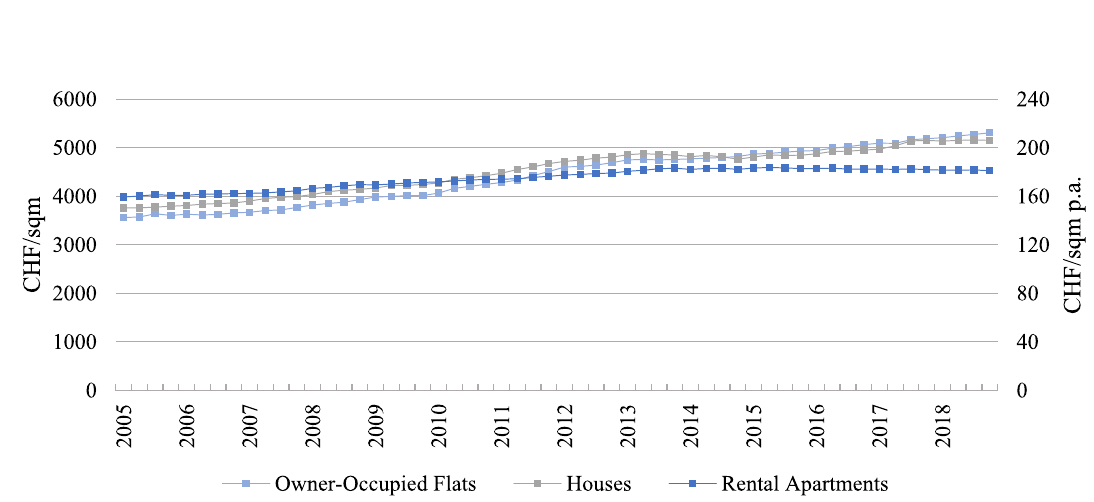
Fig. 5 Residential housing—real estate prices. Notes : Average median real estate prices across 106 MS-regions of Switzerland for houses, owner-occupied flats and rental apartments between 2005 Q1 and 2018 Q4. The left axis indicates the price development of houses and owner-occupied flats (CHF/sqm), whereas the right axis refers to yearly rental prices per square meter (CHF/sqm p.a.). Source : Wüest Partner